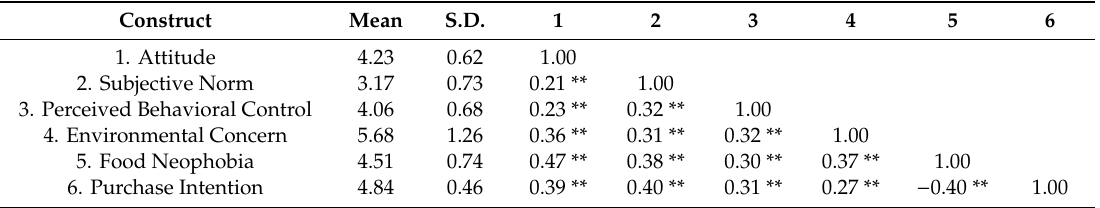
Table 2. Means, standard deviations, and correlations of constructs.